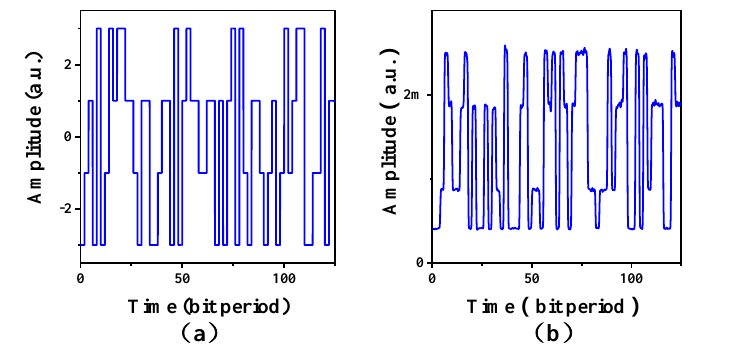
Fig. 2. (a) Time-domain waveform before transmission; (b) Time-domain waveform after transmission.